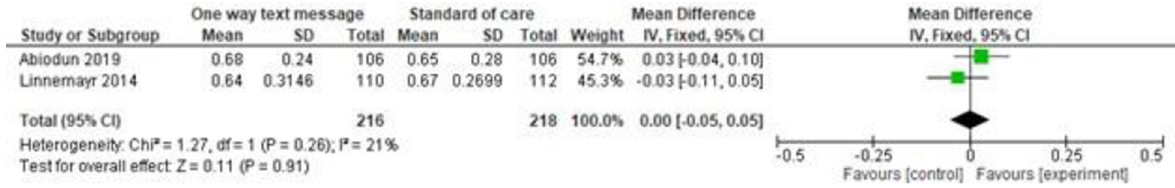
Fig 4. Forest plot of a sub-group analysis of one-way text message versus standard of care for ART adherence.